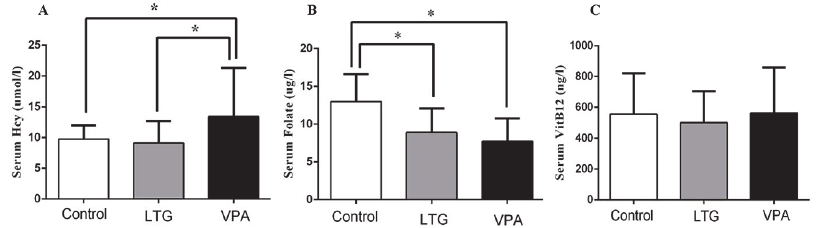
Fig 1. Comparison of serum OCM nutrient levels among the control, LTG and VPA groups. A serum Hcy levels, B serum FA levels and C serum VitB12 levels. * P < 0.05. Abbreviations : Hcy: homocysteine; FA: folate; VitB12: vitamin B12; LTG: lamotrigine; VPA: valproate.